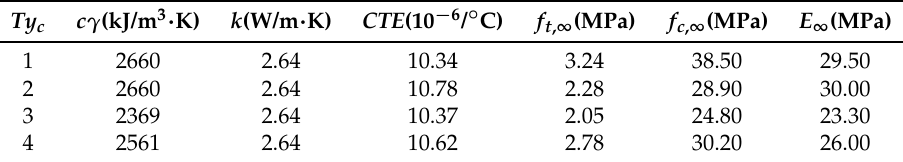
Figure 4. Adiabatic temperature rise curves. Table 2. Thermo-mechanical parameters for the